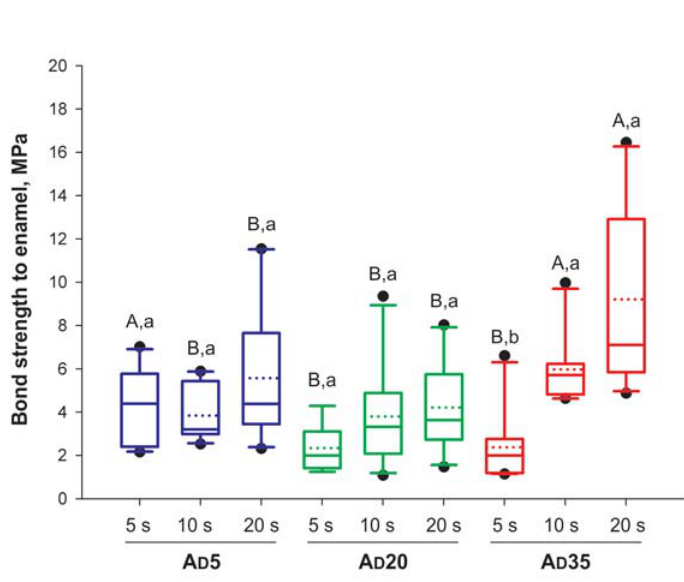
Figure 1- (cid:3)(cid:53)(cid:72)(cid:86)(cid:88)(cid:79)(cid:87)(cid:86)(cid:3)(cid:73)(cid:82)(cid:85)(cid:3)(cid:72)(cid:81)(cid:68)(cid:80)(cid:72)(cid:79)(cid:3)(cid:69)(cid:82)(cid:81)(cid:71)(cid:3)(cid:86)(cid:87)(cid:85)(cid:72)(cid:81)(cid:74)(cid:87)(cid:75)(cid:3)(cid:11)(cid:81)(cid:32)(cid:20)(cid:19)(cid:12)(cid:17)(cid:3)(cid:54)(cid:82)(cid:79)(cid:76)(cid:71)(cid:3)(cid:68)(cid:81)(cid:71)(cid:3)(cid:71)(cid:82)(cid:87)(cid:87)(cid:72)(cid:71)(cid:3)(cid:75)(cid:82)(cid:85)(cid:76)(cid:93)(cid:82)(cid:81)(cid:87)(cid:68)(cid:79)(cid:3)(cid:79)(cid:76)(cid:81)(cid:72)(cid:86)(cid:3)(cid:90)(cid:76)(cid:87)(cid:75)(cid:76)(cid:81)(cid:3)(cid:72)(cid:68)(cid:70)(cid:75)(cid:3)(cid:69)(cid:82)(cid:91)(cid:3)(cid:76)(cid:81)(cid:71)(cid:76)(cid:70)(cid:68)(cid:87)(cid:72)(cid:3)(cid:87)(cid:75)(cid:72)(cid:3)(cid:80)(cid:72)(cid:71)(cid:76)(cid:68)(cid:81)(cid:86)(cid:3)(cid:68)(cid:81)(cid:71)(cid:3)(cid:80)(cid:72)(cid:68)(cid:81)(cid:86)(cid:15)(cid:3) (cid:85)(cid:72)(cid:86)(cid:83)(cid:72)(cid:70)(cid:87)(cid:76)(cid:89)(cid:72)(cid:79)(cid:92)(cid:17)(cid:3)(cid:56)(cid:83)(cid:83)(cid:72)(cid:85)(cid:70)(cid:68)(cid:86)(cid:72)(cid:3)(cid:79)(cid:72)(cid:87)(cid:87)(cid:72)(cid:85)(cid:86)(cid:3)(cid:76)(cid:81)(cid:71)(cid:76)(cid:70)(cid:68)(cid:87)(cid:72)(cid:3)(cid:71)(cid:76)(cid:73)(cid:73)(cid:72)(cid:85)(cid:72)(cid:81)(cid:70)(cid:72)(cid:86)(cid:3)(cid:68)(cid:80)(cid:82)(cid:81)(cid:74)(cid:3)(cid:80)(cid:68)(cid:87)(cid:72)(cid:85)(cid:76)(cid:68)(cid:79)(cid:86)(cid:30)(cid:3)(cid:79)(cid:82)(cid:90)(cid:72)(cid:85)(cid:70)(cid:68)(cid:86)(cid:72)(cid:3)(cid:79)(cid:72)(cid:87)(cid:87)(cid:72)(cid:85)(cid:86)(cid:3)(cid:76)(cid:81)(cid:71)(cid:76)(cid:70)(cid:68)(cid:87)(cid:72)(cid:3)(cid:86)(cid:76)(cid:74)(cid:81)(cid:76)(cid:191)(cid:70)(cid:68)(cid:81)(cid:87)(cid:3)(cid:71)(cid:76)(cid:73)(cid:73)(cid:72)(cid:85)(cid:72)(cid:81)(cid:70)(cid:72)(cid:86)(cid:3)(cid:68)(cid:80)(cid:82)(cid:81)(cid:74)(cid:3)(cid:85)(cid:88)(cid:69)(cid:69)(cid:76)(cid:81)(cid:74)(cid:3) (cid:87)(cid:76)(cid:80)(cid:72)(cid:86)(cid:3)(cid:11)(cid:83)(cid:31)(cid:19)(cid:17)(cid:19)(cid:24)(cid:12)